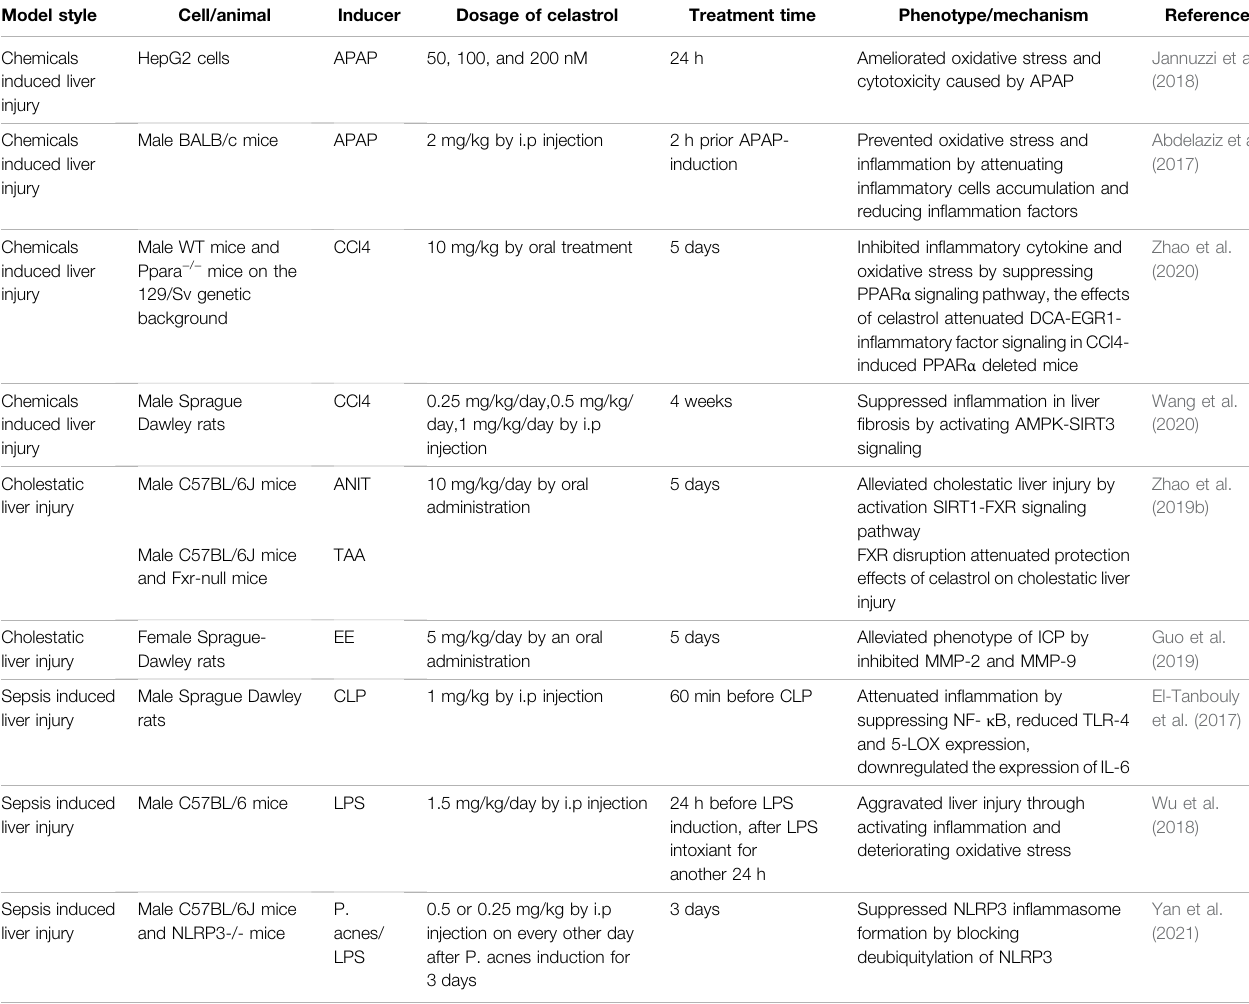
TABLE 3 | Pharmacological activities of celastrol in the treatment of liver